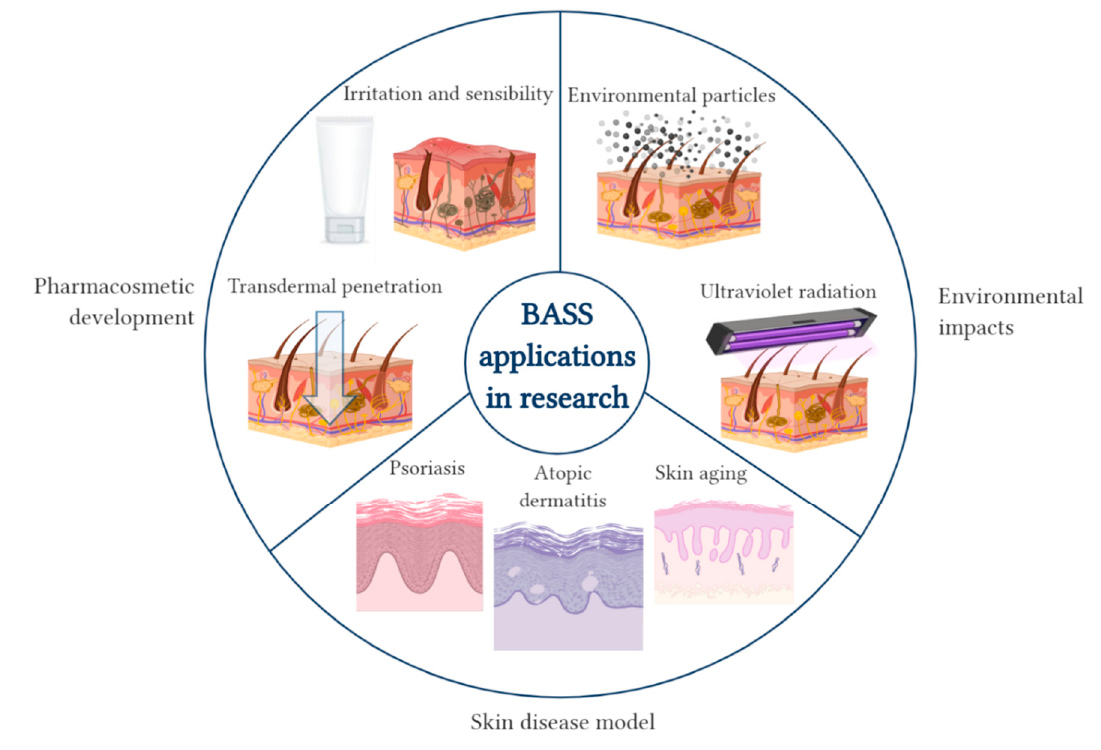
Figure 2. Diagram of the applications of BASS in research: pharmacosmetic development, environmental impacts and skin disease models. Created with BioRender.com.